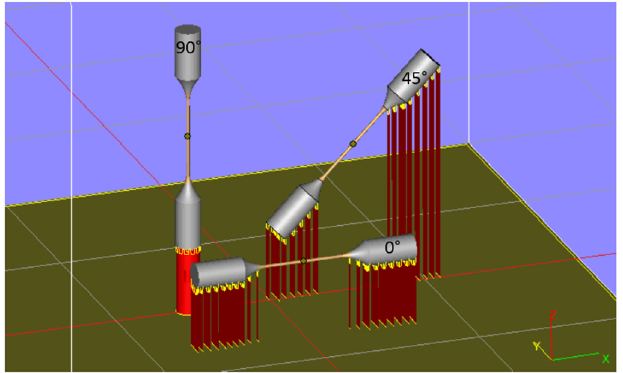
Figure 2. Growth orientation investigated in Magics Materialise environment.